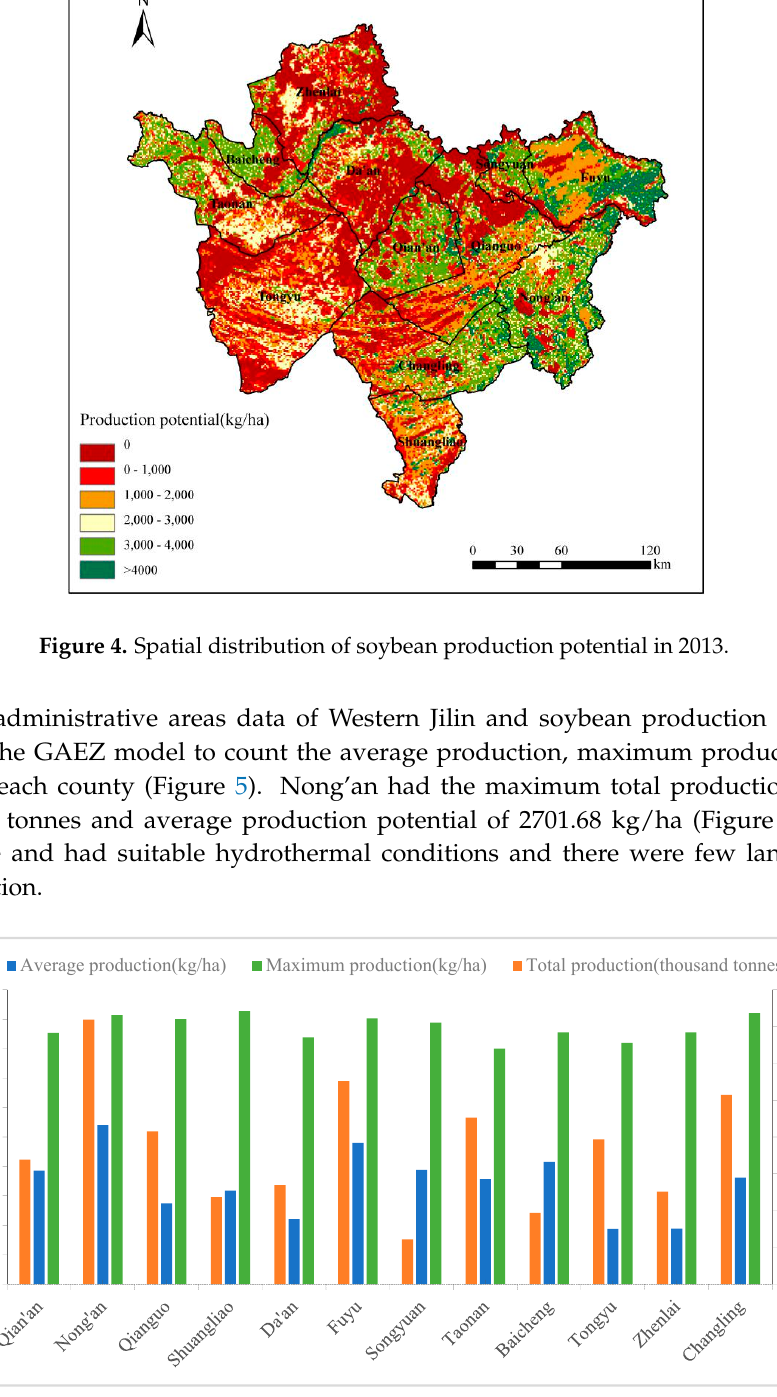
Figure 5. Soybean production potential in Western Jilin in 2013.